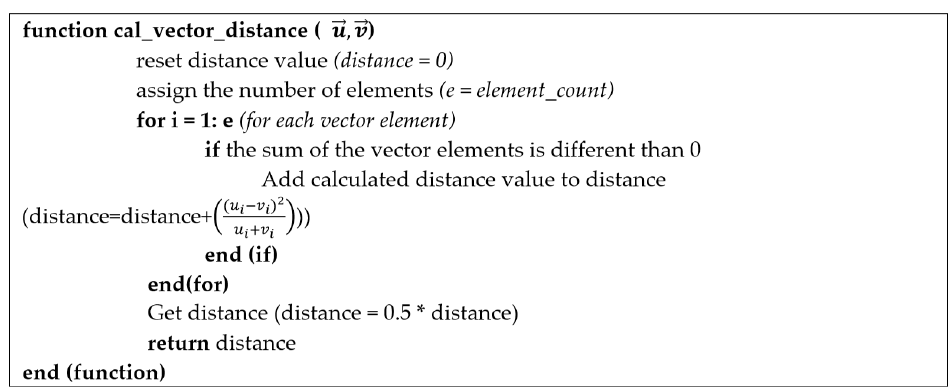
Figure 11. Calculation of the distance between two vectors is the pseudo code.